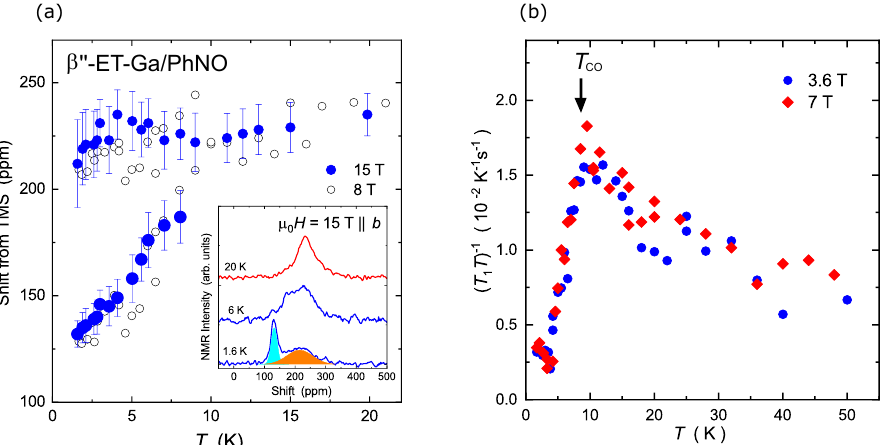
Figure 6. ( a ) Temperature dependence of the NMR shift at 15 T and 8 T [48]. The vertical axis is the peak shift from tetramethylsilane (TMS). The field-independent peak separation at the lowest temperature indicates the absence of any fixed internal field that could be associated with a magnetic transition. Inset shows 13 C-NMR spectra at various temperatures. The peak splitting starts below 8 K, and a clearly split two-peak structure was observed at 1.6 K. The ratio of the integrated area between the sharp (cyan) and broad (orange) peaks was evaluated as 0.4:1. ( b ) Temperature dependences of 1/ T 1 T measured at 3.6 and 7 T [47]. The peaks at T CO were found in both fields,